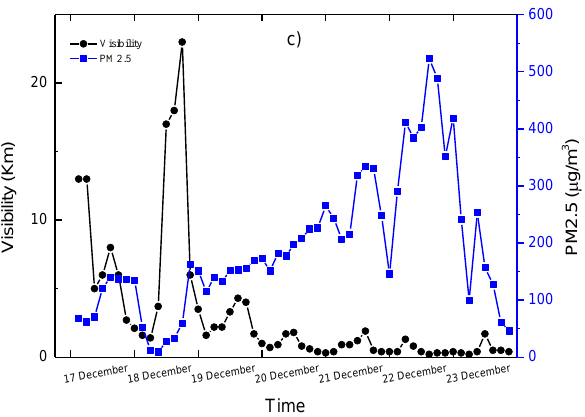
Figure 3. Temporal variation of meteorological parameters and pollutants from 17 to 23 December 2015: ( a ) temperature (°C) and RH (%); ( b ) visibility (km) and RH (%); ( c ) visibility (km) and PM 2.5 concentration ( µ g/m 3 ) (meteorological dataset).